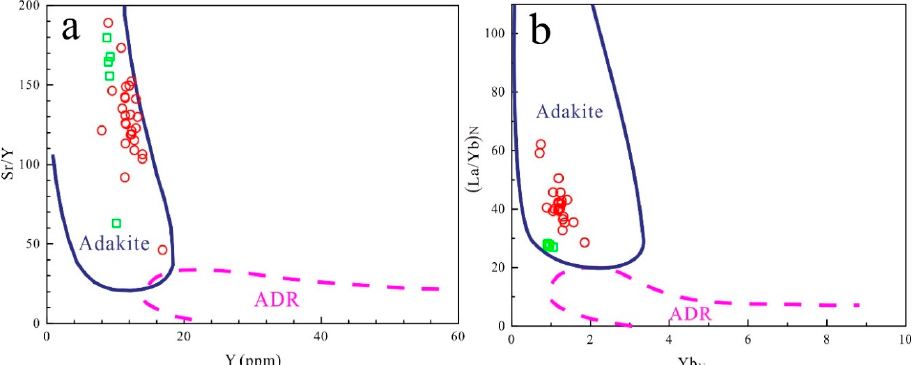
Figure 10. Classification diagrams of ( a ) Sr/Y vs. Y and ( b ) (La/Yb) N vs. Yb N for diorites from the Yueshan and Zongpu after [15]. ADR: normal andesites, dacites and rhyolites. The boundaries between ADR and adakite are taken from [65]. Symbols are as in Figure 4.